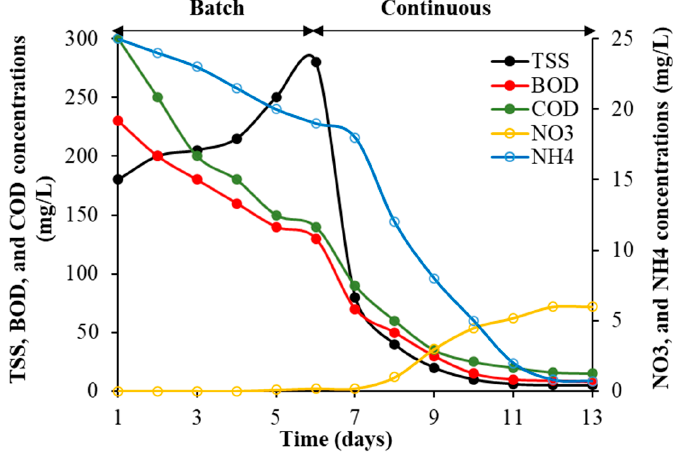
Figure 4. Start-up performance of the MBBR system. NO 3 and NH 4 concentration on the right vertical axes and TSS, BOD and COD on the left vertical axes.